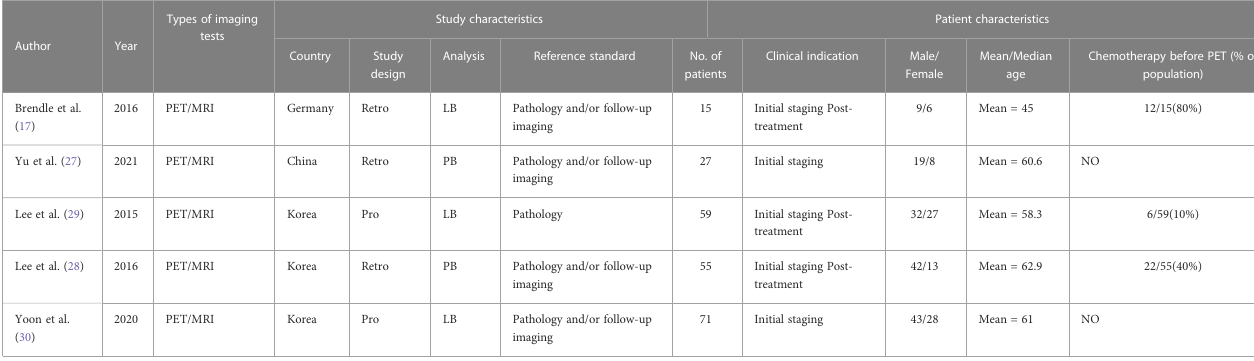
PB, patient-based; LB, lesion-based; Pro, prospective; Retro, retrospective; NA, not available.